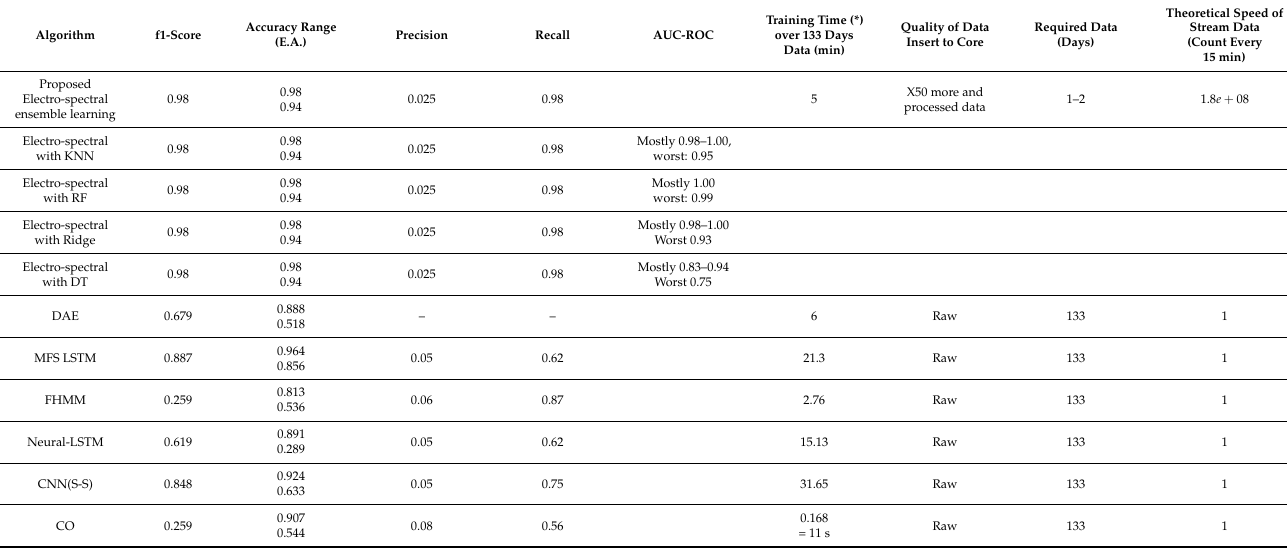
Table 1. Empirical accuracy and quality comparative table. Metric data taken from references [4,59,62] and the current research in this paper. All results were obtained using Statec TM PM 180 smart meter. Algorithm f1-Score AccuracyRange (E.A.) QualityofData